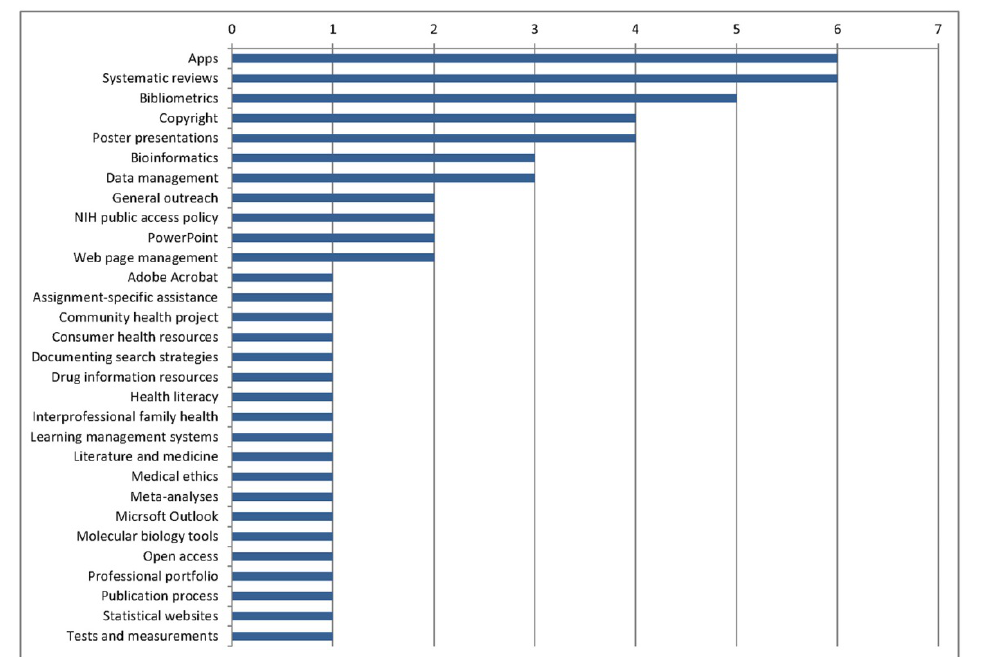
Figure 1 Other category: instruction